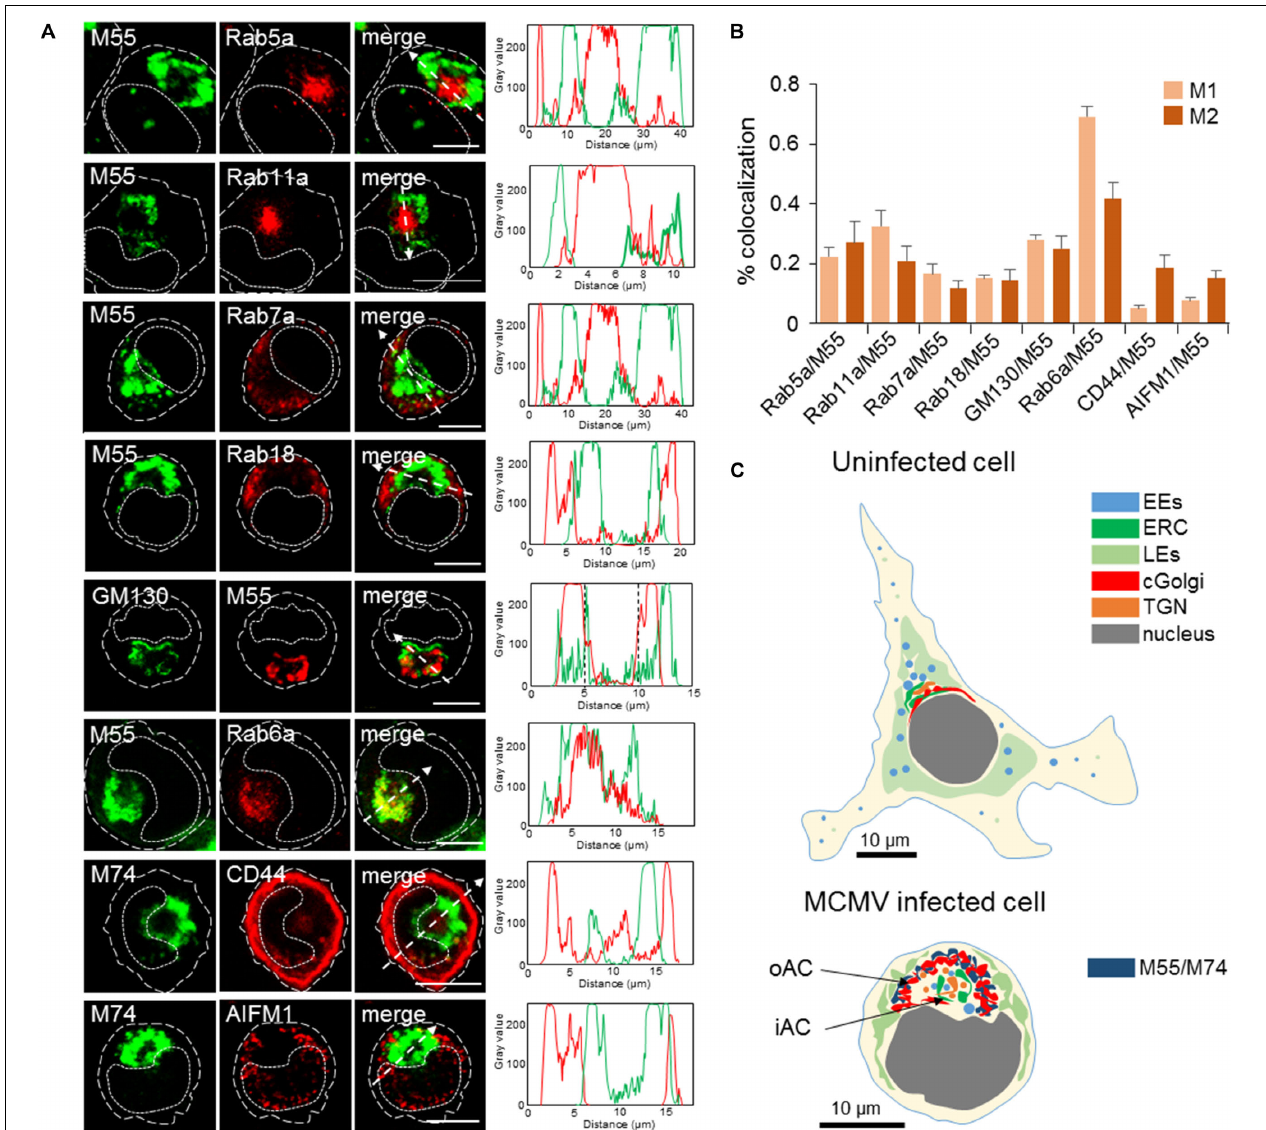
FIGURE 3 | Subcellular distribution patterns of classical steady-state organelles at 48 hpi with MCMV. (A) The steady-state organelles were visualized using Ab reagents to cellular proteins that characterize EEs (Rab5), the ERC (Rab11), LEs (Rab7), trans-Golgi and TGN (Rab6), cis/medial-Golgi (GM130), ER (Rab18), cortical endomembrane system (CD44), and mitochondria (AIFM1). The sites of intracellular accumulation of viral envelope glycoproteins were visualized using mAb reagents to MCMV proteins M55 and M74. Antibody reagents used are listed in Supplementary Table S1 , and each marker described in Supplementary Table S2 . Colocalization analysis was performed by plotting fluorescence intensity profiles along white dashed lines and shown in the right column. Cell borders are indicated by fine dashed lines and nuclei by fine dotted lines. Bars, 10 µ m. (B) Colocalization analysis of classical steady-state organelle markers with M55/M74 based on M1/M2 coefficients of pixel overlap. Data represent mean ± SEM per cell ( n = 8–12). (C) Schematic presentation of major organelle localization in uninfected and MCMV-infected Balb-3T3 fibroblasts. The cytoplasmic area of an uninfected cell can be divided into three zones according to the distribution of membranous organelles: cortical, perinuclear, and juxtanuclear. The cortical zone of the cell can be confined by visualization of CD44 distribution, perinuclear zone by visualization of LEs using LBPA as a marker, and juxtanuclear zone by simultaneous visualization of LEs (using LBPA as a marker) and internalized TfR (see Supplementary Figure S9 ). The bottom image presents a schematic outline of cytoplasmic area zones in MCMV infected cells at 48 hpi. 11/2 -column fitting image.